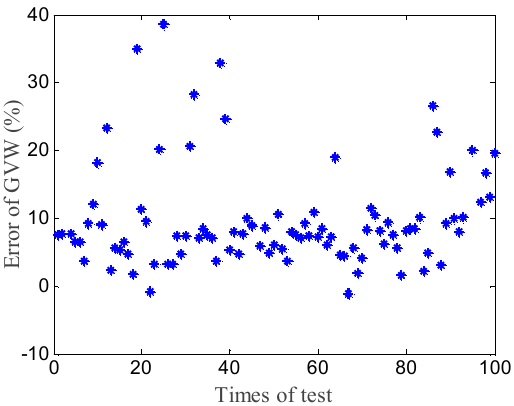
Figure 13. The identified errors of the GVW with 20% noise when d = 36cm.